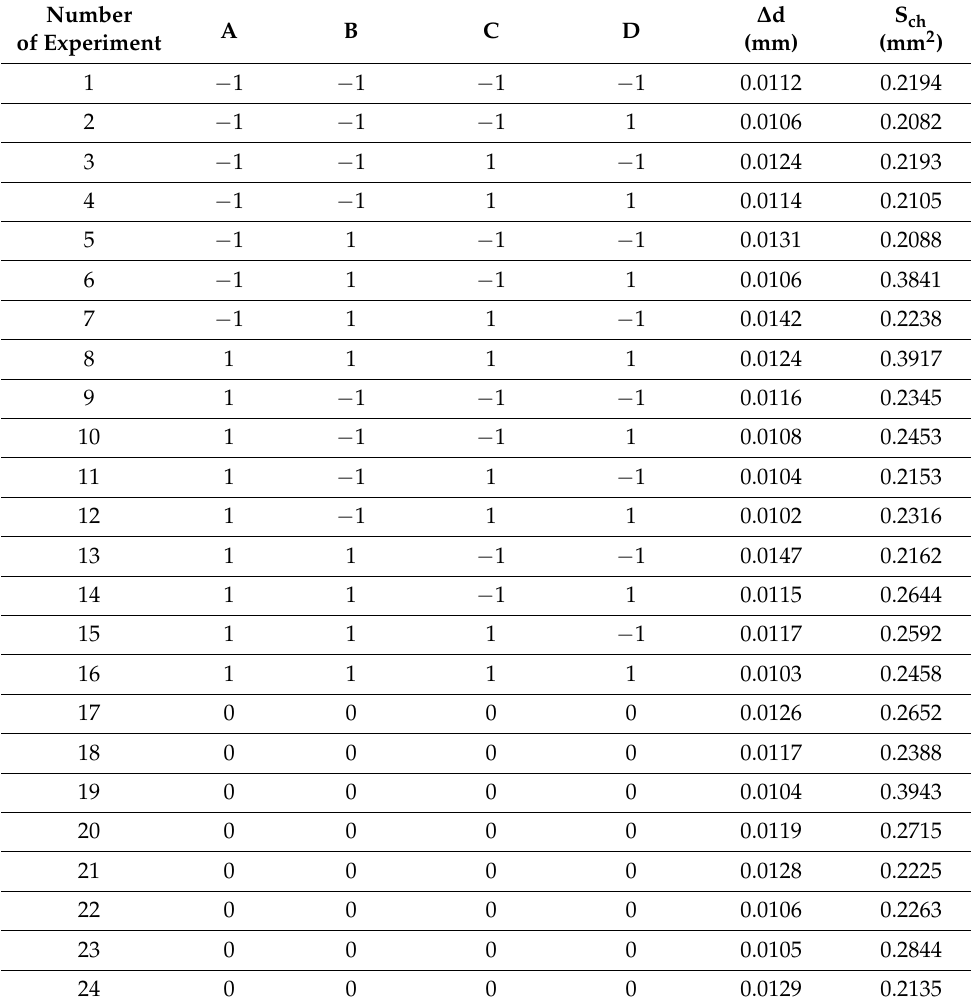
Table 5. Experimental plan